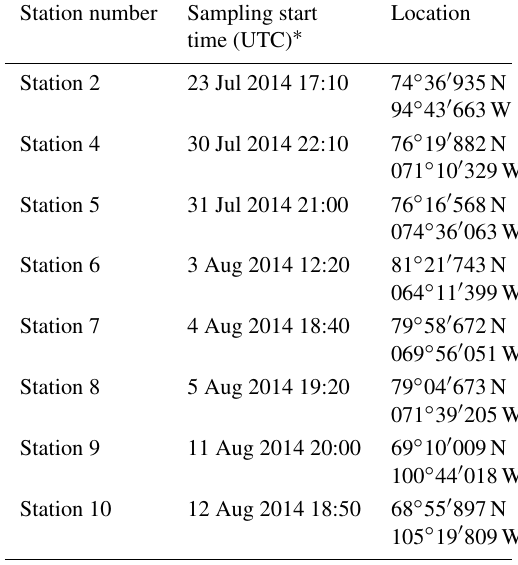
Table 1. Sampling times and geographic coordinates for the eight stations investigated during July–August 2014 in the Canadian Arc-